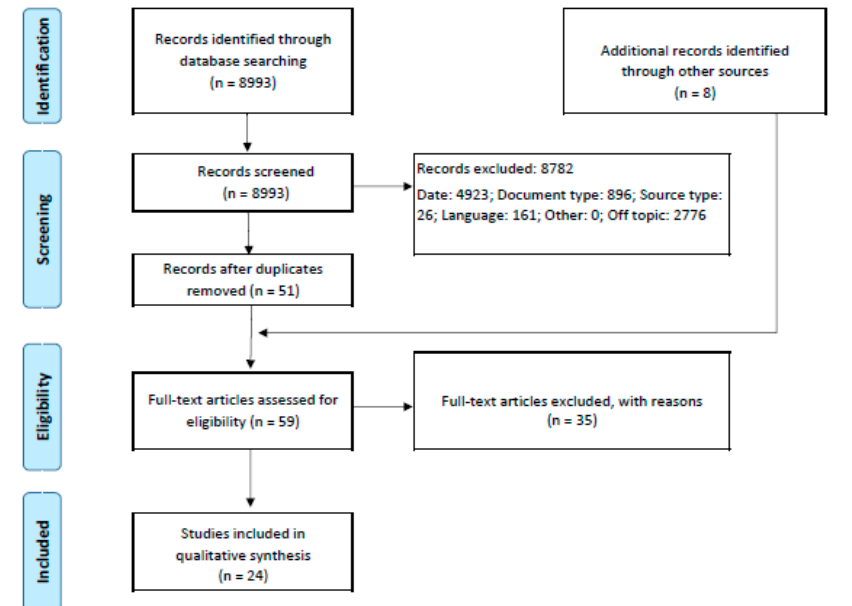
Figure 1. Summary of the research, adapted from Moher et al. [39].